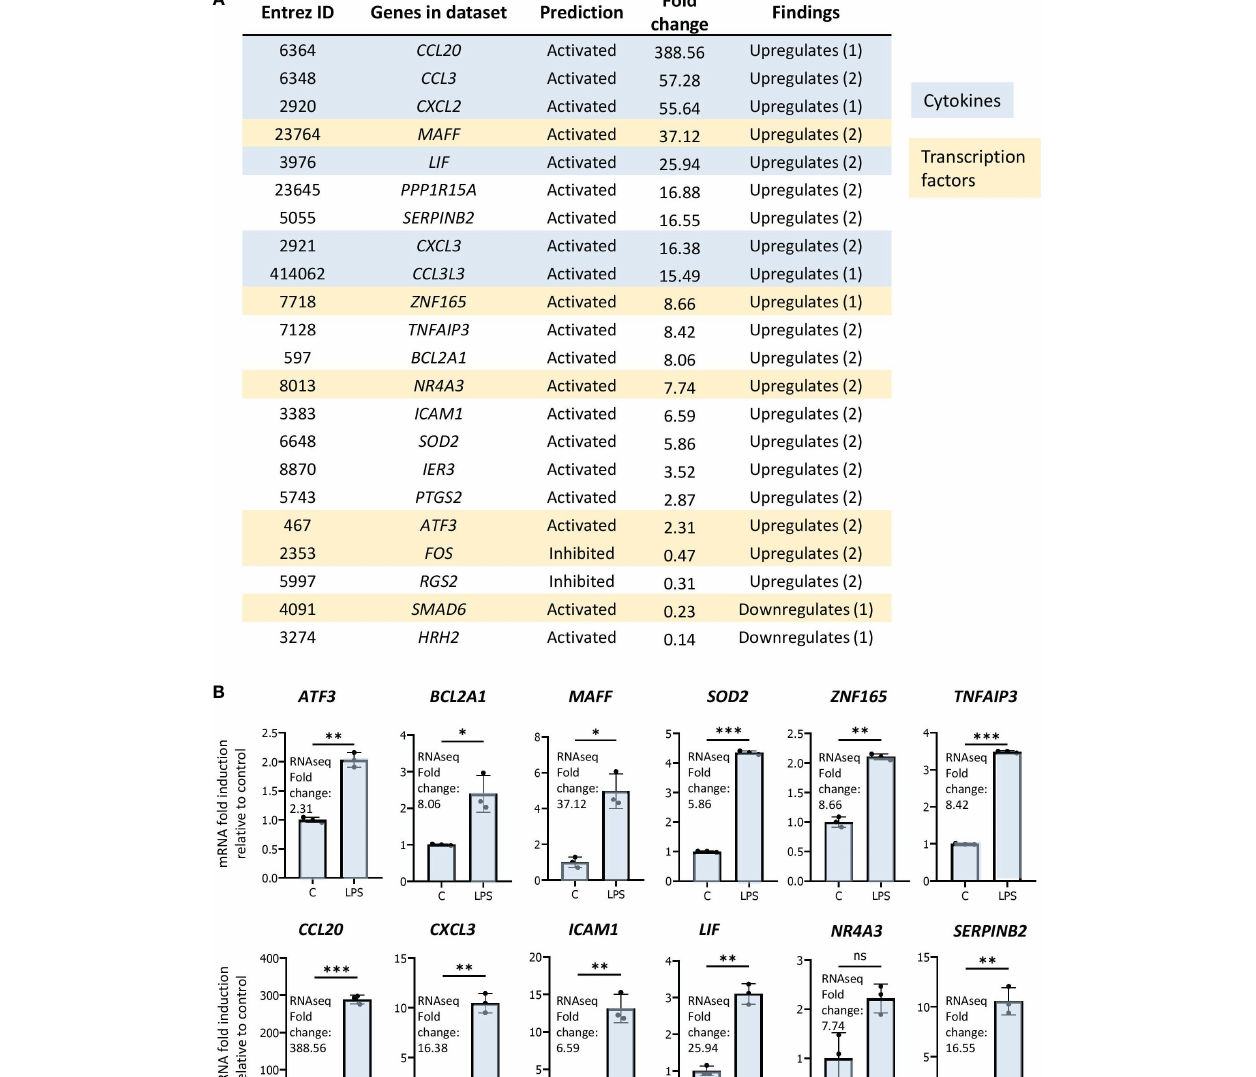
either of the two proteins (Figure 7A). FOXP1 and FOXP4 expression was observed in cells transiently transfected with corresponding expression vectors (Figure 7A). ChIP assays were performed to analyse binding of the two proteins to multiple binding sites identi fi ed above. FOXP4 binding was observed to all sites (Figure 7B). Remarkably, robust binding of FOXP1 by ChIP was also observed to all sites (Figure S7C), with the strongest signals at sites adjacent to the ATF3 and SOD2 genes. Importantly, we also observed a general increase in mRNA expression of multiple network genes in transfected HEK293 cells (Figure 7C). Taken together, these data show that expression of network genes is induced under conditions of elevated forkhead box transcription factor expression.